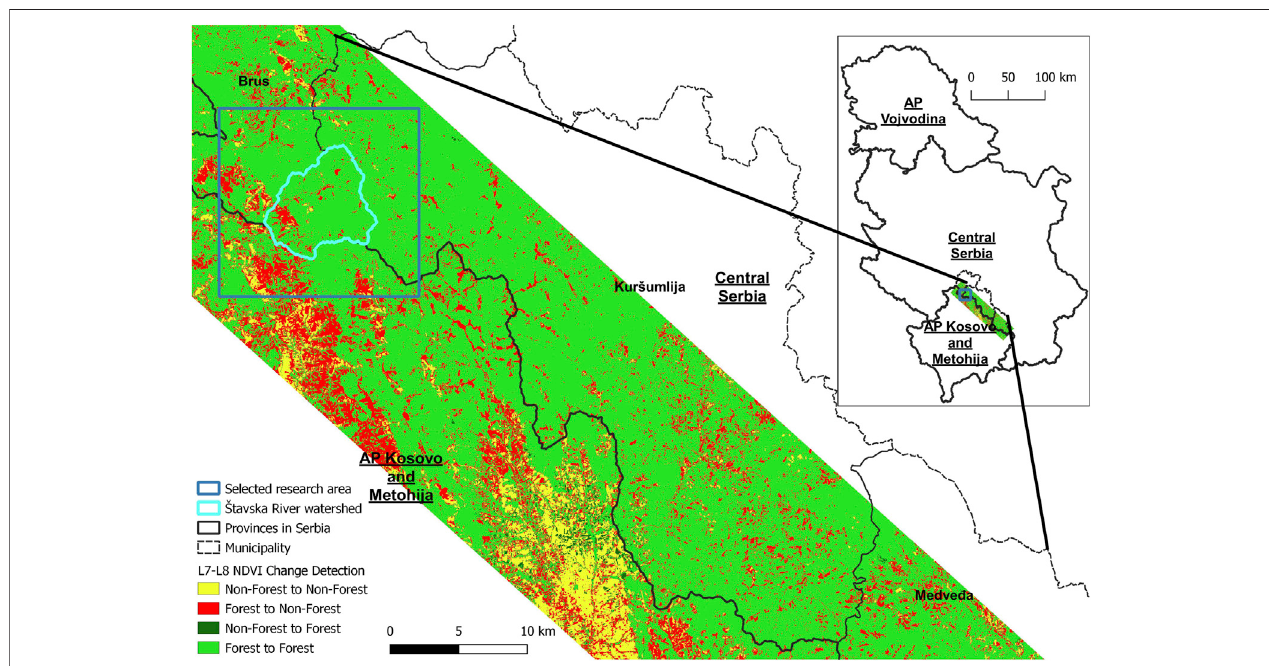
FIGURE 1 | The southern part of the Republic of Serbia with Research area - NDVI change detection map.